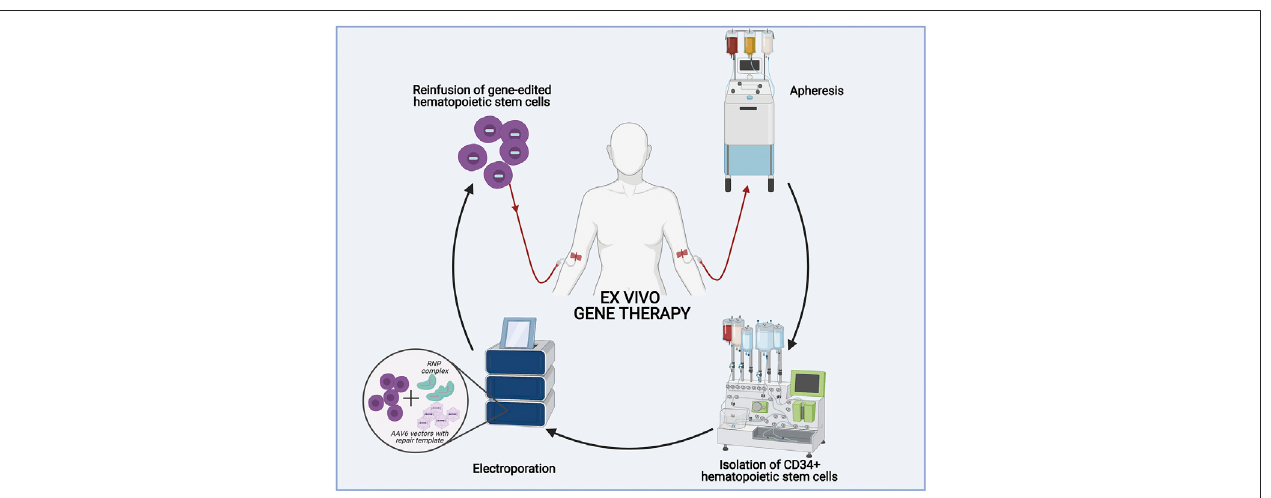
FIGURE 6 | Principles of ex vivo gene editing. For a patient speci fi c treatment, CD34 + hematopoietic stem cells are isolated from a patient ’ s blood through apheresisfollowedbyanautomatedcellprocessingsystemthatenrichCD34 + cells.Afterwards,thegenomeeditingtools(Cas9andsgRNA)aredeliveredtothecellsby electroporation and the DNA repair templates are delivered by addition of AAV6 vectors to the cell culture. The genetically modi fi ed cells can be cryopreserved before infusion into the patient, which has typically undergone myeloablative conditioning prior to